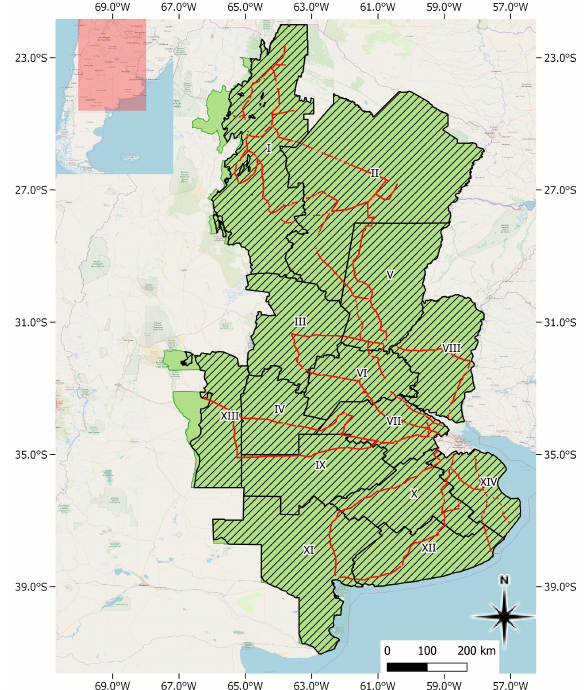
Figure 1. Study region covering Pampa and Chaco, the main agricultural areas of Argentina. Green: Buenos Aires Grain Exchange zonation; Shaded: Modified zonation; red lines: on road surveys.